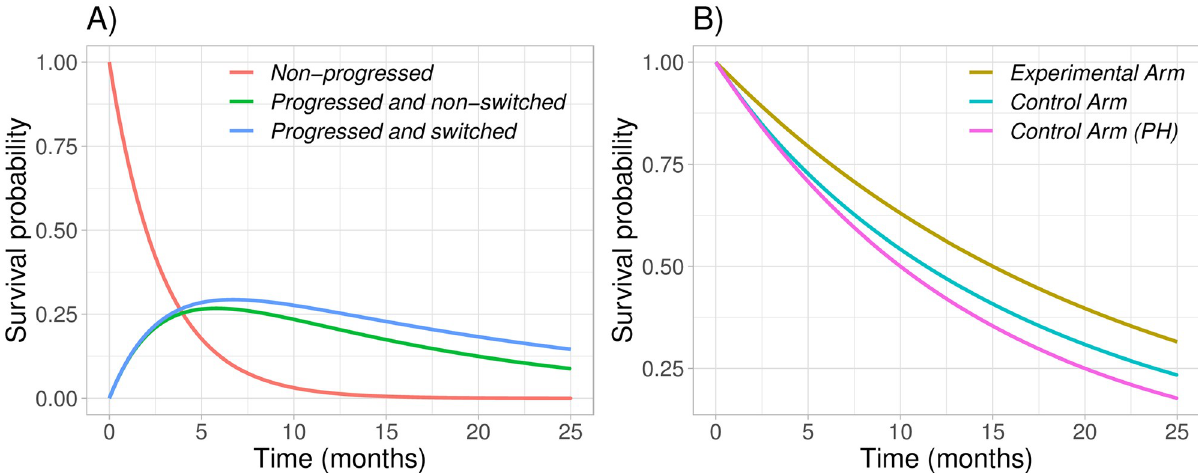
Fig 4. Plot A shows the survival probability for non-progressed patients (red), progressed and non-switched patients (green) and progressed and switched patients (blue) assuming p = 0.5, m